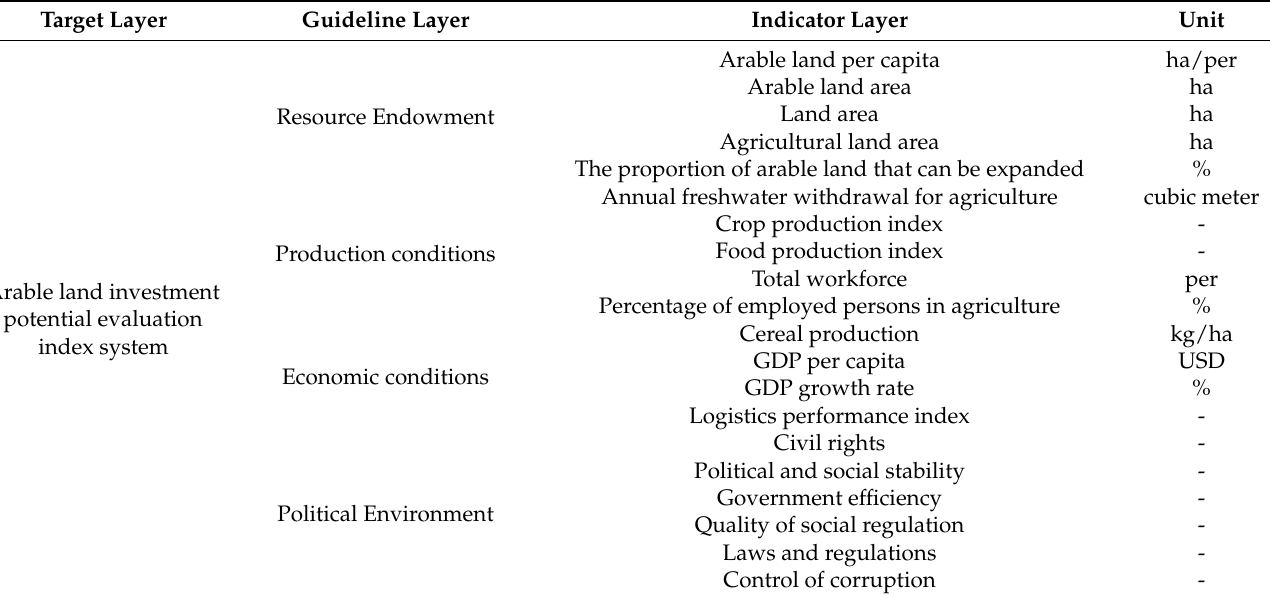
Table 2. Evaluating the index system of arable land investment